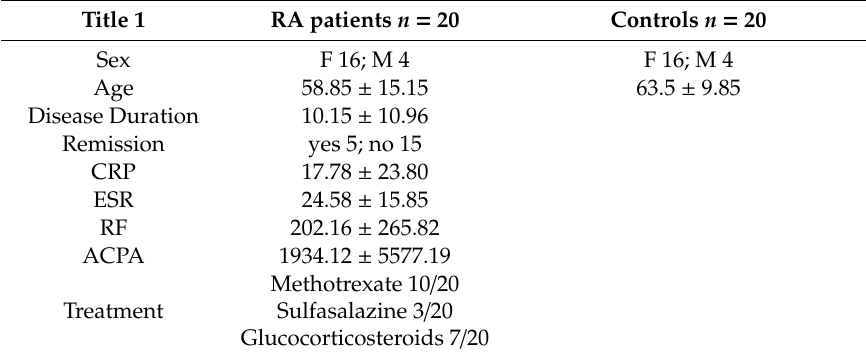
Table 1. Clinical characteristics of the studied group. CRP (C-reactive protein), ESR (erythrocyte sedimentation rate), RF (rheumatoid factor), ACPA (anti-citrullinated peptide antibodies), GCS (glucocorticosteroids), F-Female,